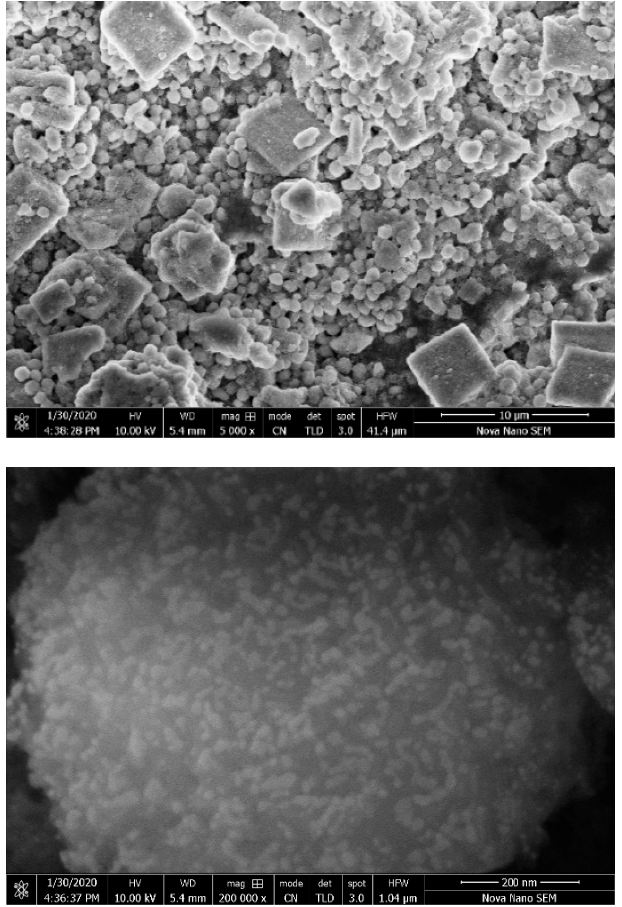
Figure 9. SEM images of WH-6 product with rhombohedral crystals.